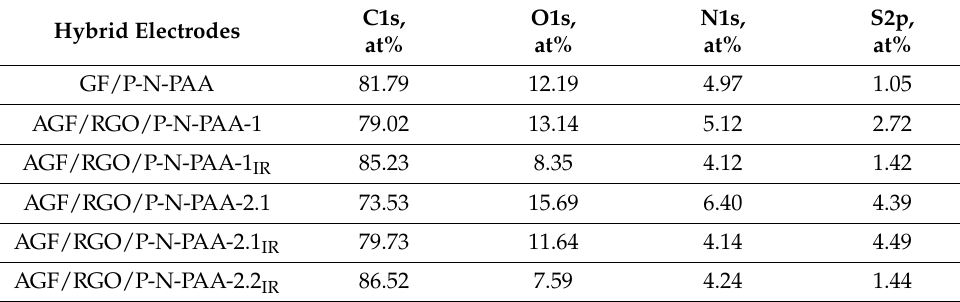
Table 3. XPS elemental composition of hybrid electrodes.